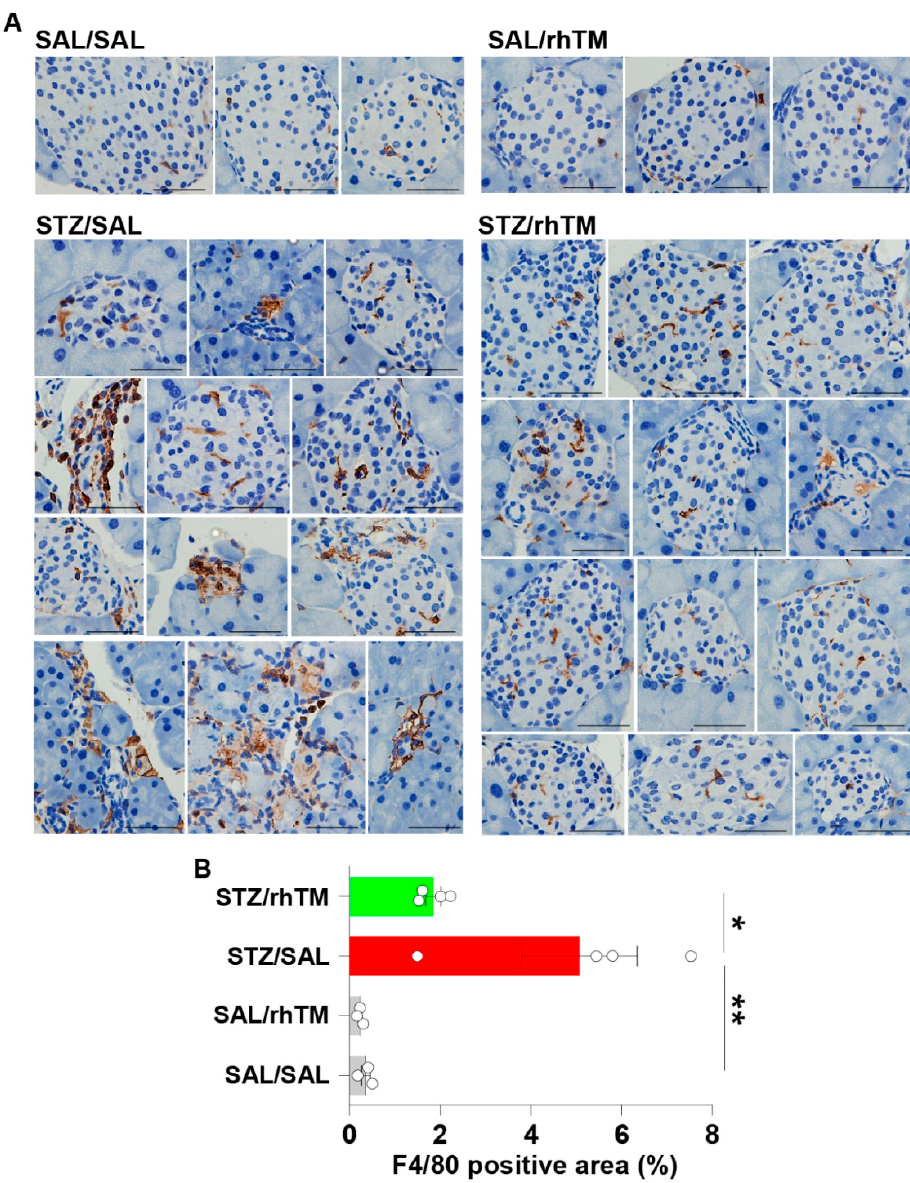
Figure 4. Treatment of diabetic mice with recombinant human thrombomodulin reduced islet infiltration of macrophages. ( A ) Immunostaining of F4/80-positive cells (macrophages) in each mouse group. Scale bars indicate 50 µm. ( B ) The F4/80-positive areas were determined using the WinROOF image processing software. Data are the mean ± S.D. Statistical analysis by ANOVA and Tukey’s test. * p < 0.05, ** p < 0.01. SAL/SAL, mice received intraperitoneal injection of SAL and were treated with SAL. SAL/rhTM, mice received intraperitoneal injection of SAL and were treated with rhTM. STZ/SAL, mice received intraperitoneal injection of STZ and were treated with SAL. STZ/rhTM, mice received intraperitoneal injection of streptozotocin (STZ) and were treated with recombinant human thrombomodulin